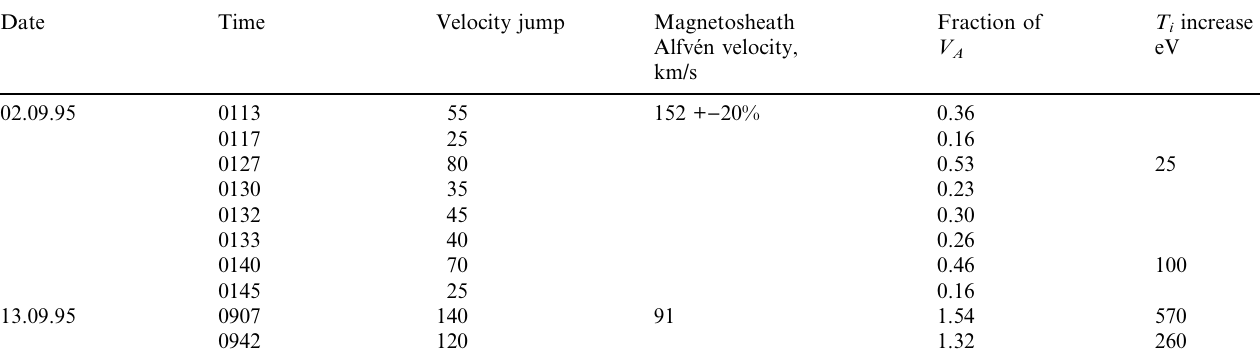
Table 2. Velocity jumps above magnetosheath value and Alfve´n velocity